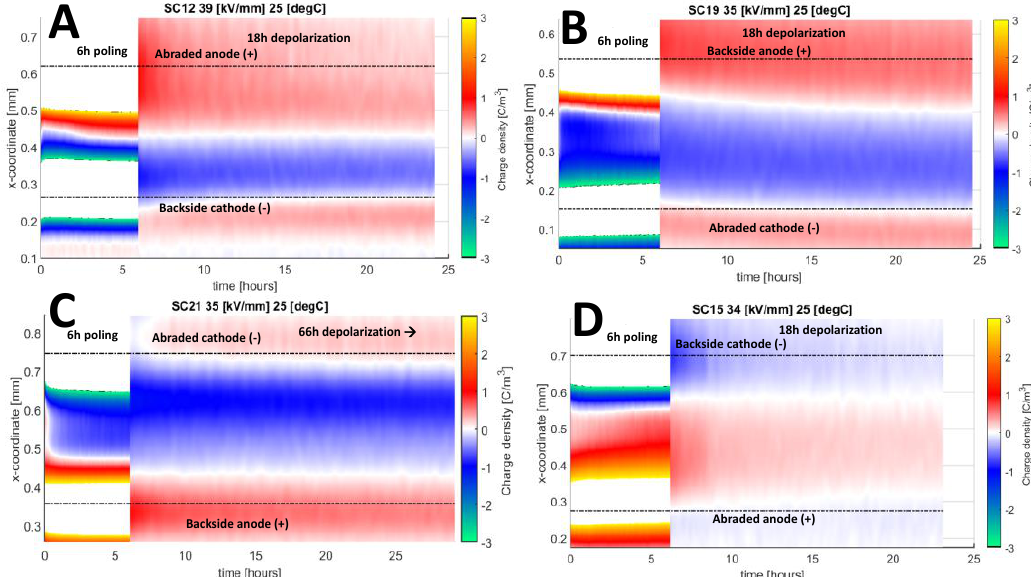
Figure 6. PEA measurements showing impact of polarity and sample orientation. 15 kV of positive or negative poling voltage was used at 25 °C. polarity and orientation of the electrode types is indicated in the figures. In each figure, SC-# indicates sample identification number, followed by the mean field strength during poling and temperature. The mean field strength is defined as poling voltage divided by sample thickness (measured post-measurement). Data larger than +/ − 3 C / m 3 have been colored white in the colormap as the electrode peaks during polarization should be disregarded in the comparison.